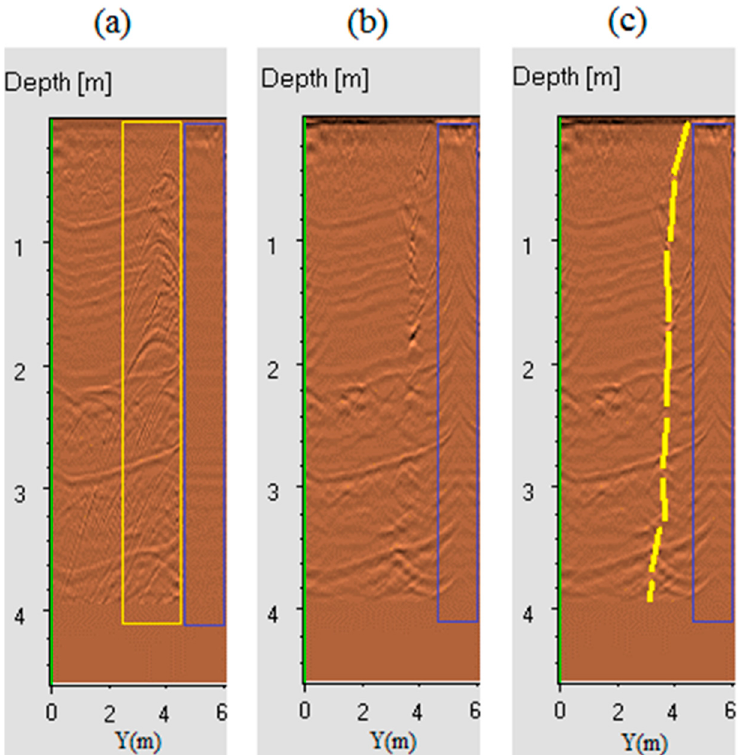
Figure 8. The antenna bumping effect shown through an example extracted from the first six meters of radargram F13 (original length equal to 65 m). ( a ) Radargram F13 processed without data migration, showing the hyperbolic diffractions of a sub-vertical fracture surface highlighted in the yellow rectangle. The blue rectangles refer to the zone of the antenna bumping. ( b ) The radargram after data migration. ( c ) Interpretation of the fracture surface. The reflection in the bumping zone is not considered.